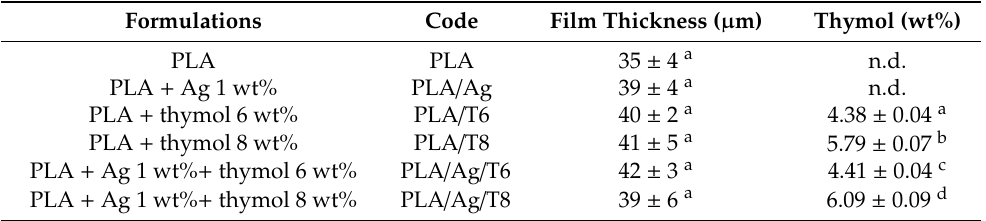
Table 1. PLA nano-biocomposites, thickness values, and amounts of thymol quantified in the active films after processing (wt%). Mean ± SD (n =